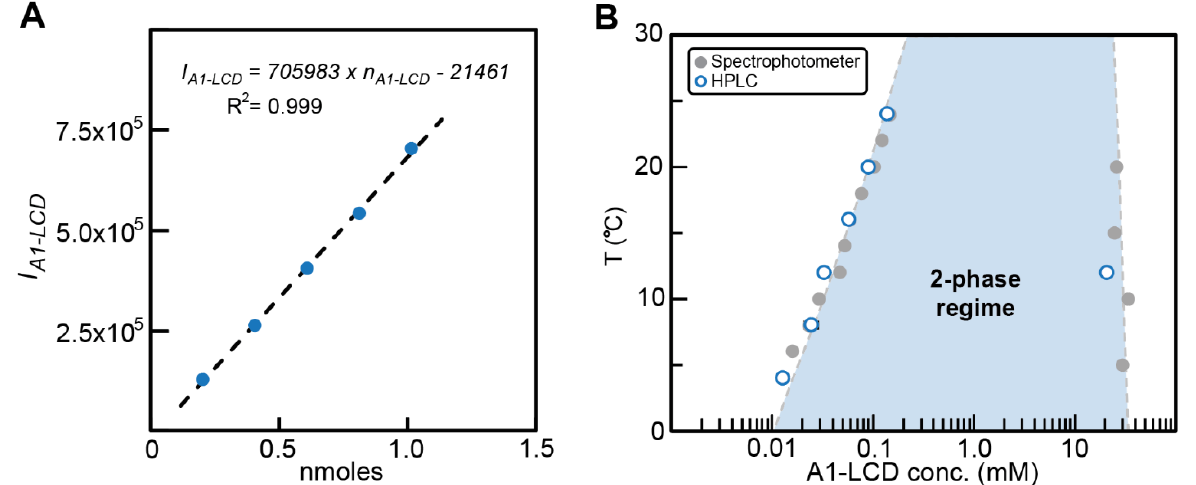
Figure 1. Schematic overview of the workflow used in this study to reconstruct phase boundaries via analytical HPLC. ( A ) Biomolecules A and B undergo phase separation when present at suitable concentrations and molar ratios. The sample is incubated for equilibration. Separation of the dense and dilute phases is achieved via centrifugation. Known volumes of dilute and dense phase are each separately injected onto the HPLC column and eluted with an appropriate method. ( B ) HPLC elution profile for a sample containing biomolecules A and B. Peaks are integrated and the concentrations of biomolecules A and B are determined using a standard curve. ( C ) The coexistence line and tie lines of biomolecules A and B can be reconstructed from the dilute and dense phase concentrations extracted from the elution profiles. The tie line connects the coexisting dilute and dense phase concentrations. A tie line or tie simplex is defined by its slope, and it identifies the components whose concentrations need to be constrained relative to one another to yield the concentrations of the coexisting phases.